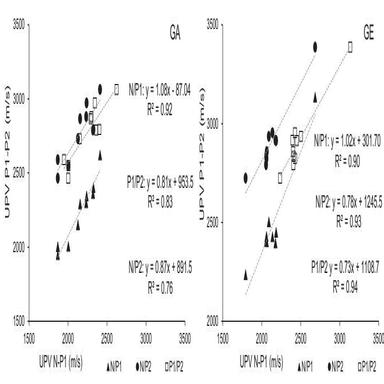
Valid linear correlations UPV readings on granites.